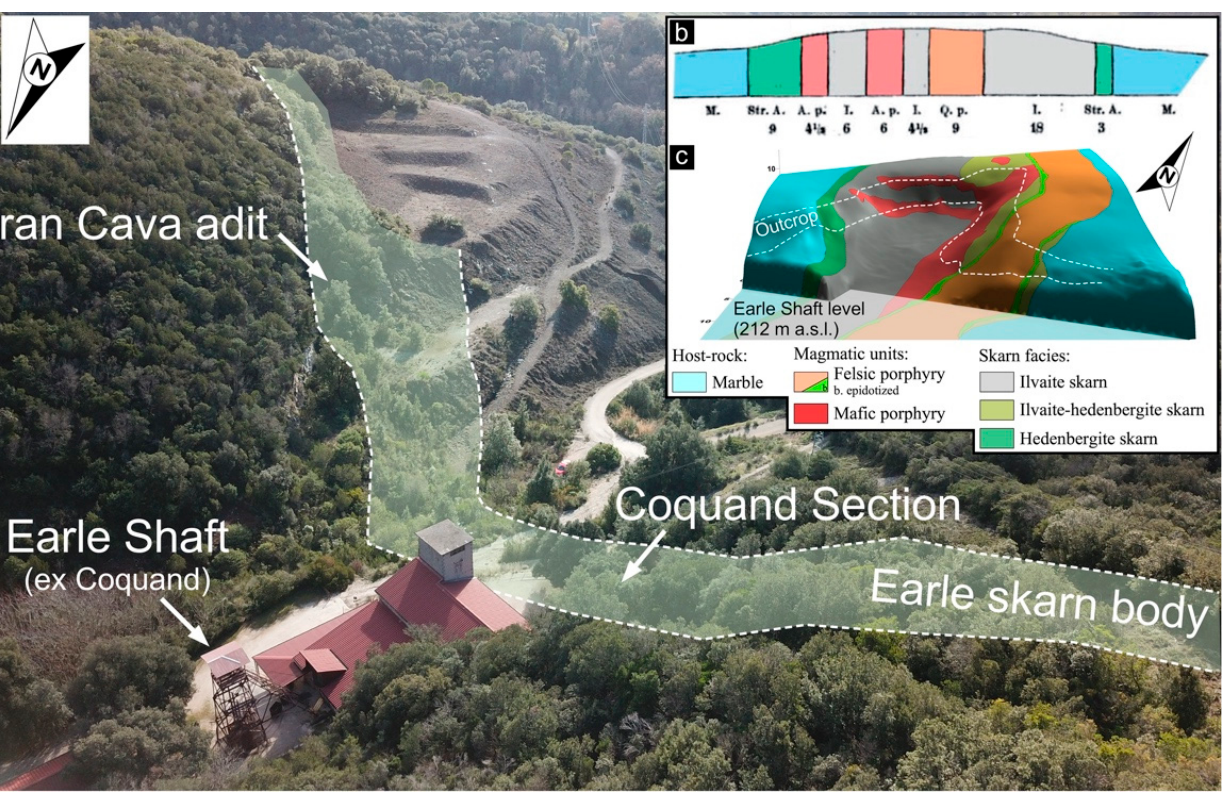
Figure 2. ( a ) Panoramic view of the Earle Shaft (Temperino mine) with schematic arrangement of Earle skarn body and location of the “Coquand Section”. ( b ) First illustration of the “Coquand Section” by vom Rath (modified from [37]). Abbreviations are referred to: M.—Marmor (marble); Str.A.—Strahliger Augit (hedenbergite facies); A. p.—Augitporphyr (mafic porphyry); I.—Ilvait (Ilvaite facies); Q. p.—Quarzporphyr (felsic porphyry). The numbers referred to the thickness of each unit in feet. ( c ) Three-dimensional geological survey of the “Coquand Section” (modified from [41]). The picture represents the most recent representation of this historical-scientific outcrop.